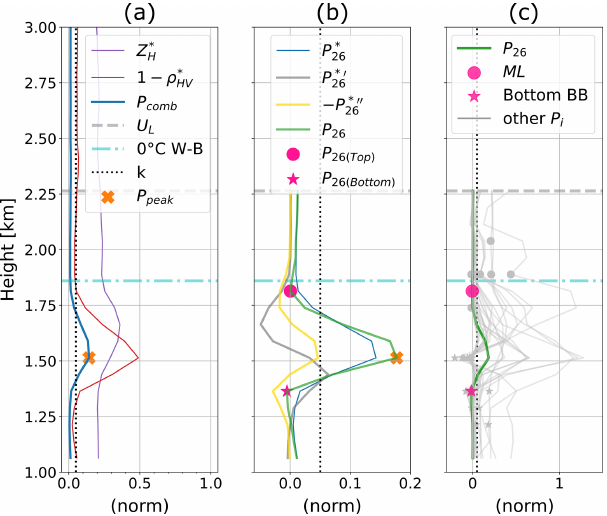
Figure 5. Depiction of the implementation of the algorithm for ML